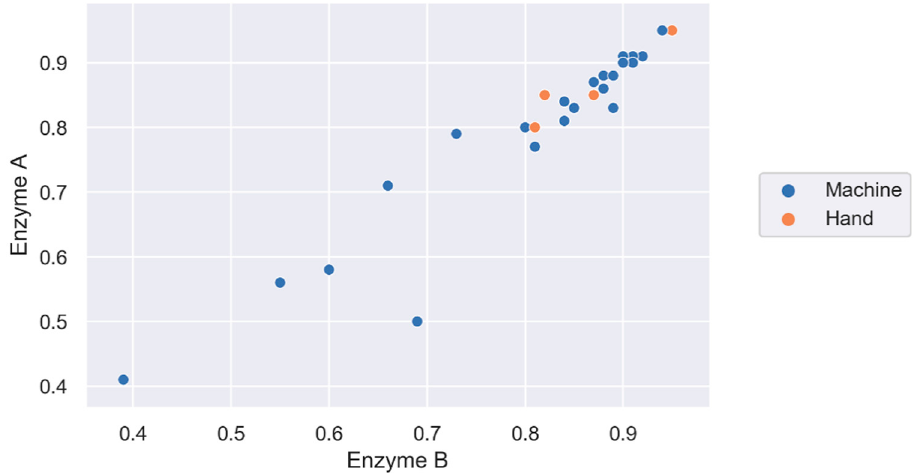
Figure 3. Relationship between harvesting method (hand vs. machine harvested) and enzyme efficiency. The axes show the enzyme efficiency index for each enzyme to allow for a sample-specific comparison.